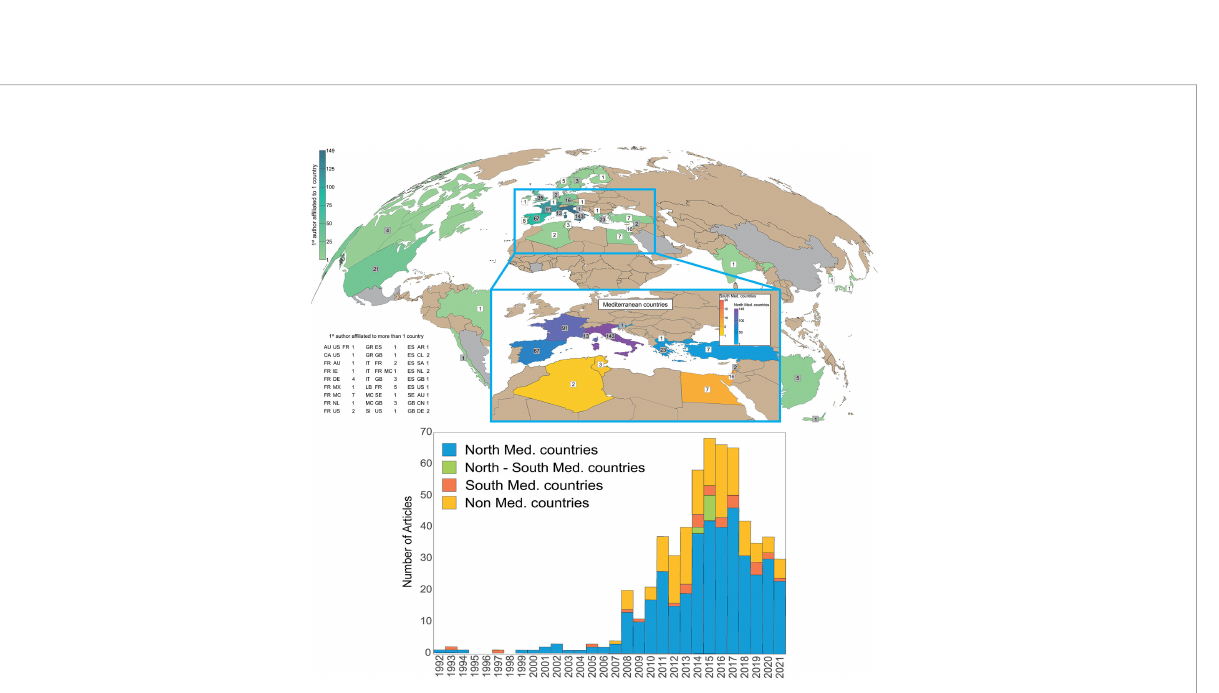
FIGURE 4 Top) Number of OA-related items per country of the 1 st /Corresponding author(s). Gray-background numbers are referring to countries having a 1 st /Corresponding author af fi liated to more than one country. In the latter case, countries ’ abbreviations are shown in details on the bottom left panel according to the UN/LOCODE Code List for every country and territory (UN/LOCODE Code List by Country and TerritoryUNECE). Bottom) The OA-related productivity in function of years for the North, South, North-South Mediterranean, and the non-Mediterranean regions.